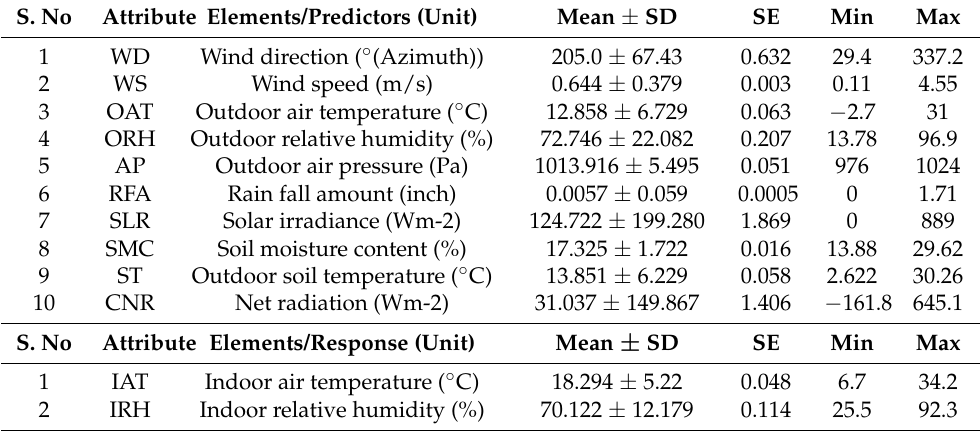
Table 1. Descriptive statistics and profile information of the outdoor/predictor data collected from weather station (Campbell scientific weather station) and indoor/response data collected from LEMS